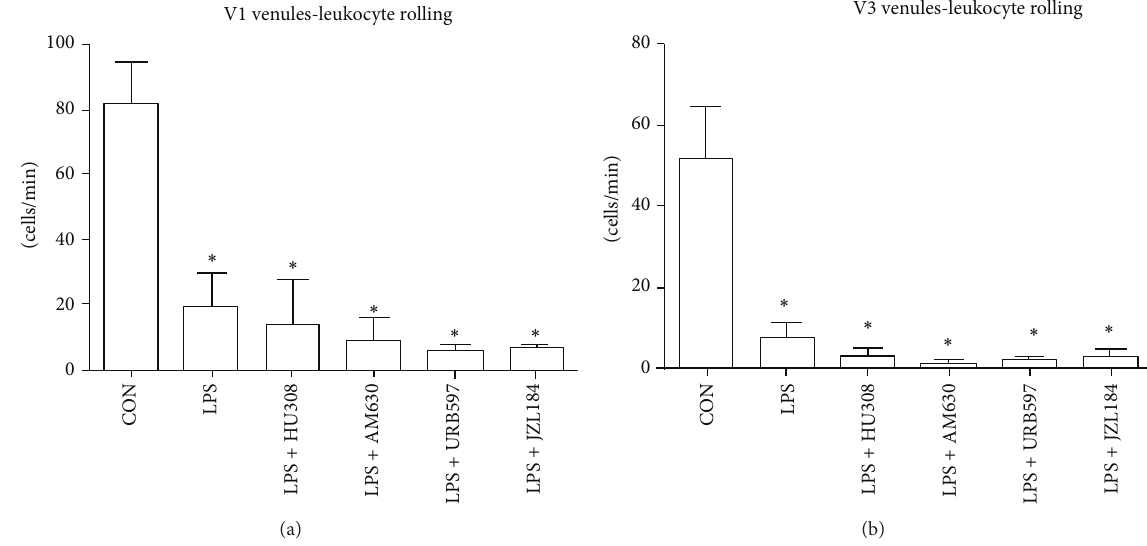
Figure 2: (a) Rolling leukocytes along collecting venules (V1; > 50 𝜇 m vessel diameter). (b) Rolling leukocytes along postcapillary venules (V3; < 50 𝜇 m vessel diameter). Control group (CON); endotoxemia group LPS (5 mg/kg); LPS + HU308 (2.5 mg/kg), a CB AM630 (2.5mg/kg), a CB 2 receptor antagonist/inverse agonist; LPS + URB597 (0.6mg/kg), a FAAH inhibitor; and LPS + JZL184 (16mg/kg), a MAGL inhibitor. In every animal six V1 venules and six V3 venules were analyzed ( 𝑛 = 3 –5 mice/group). Data presented as mean ± standard deviation. ∗ 𝑃 < 0.05 versus